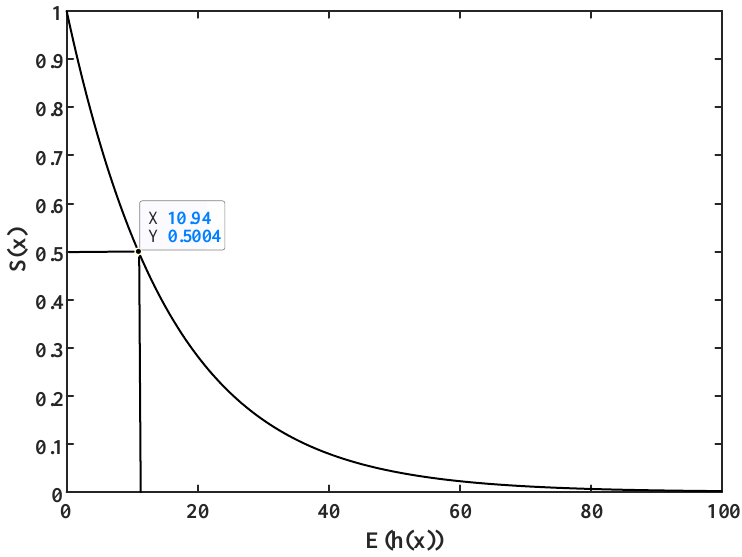
Figure 12. Distribution of abnormal scores of empty-nest users.